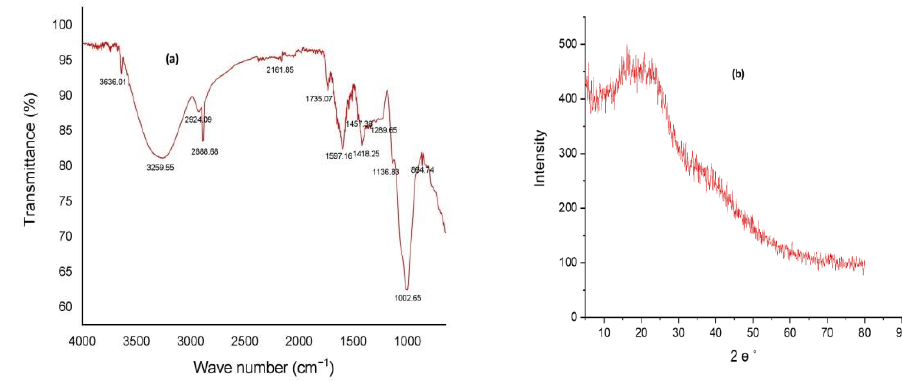
Figure 2. ( a ) FTIR spectra of purified PAG; ( b ) XRD of pure purified